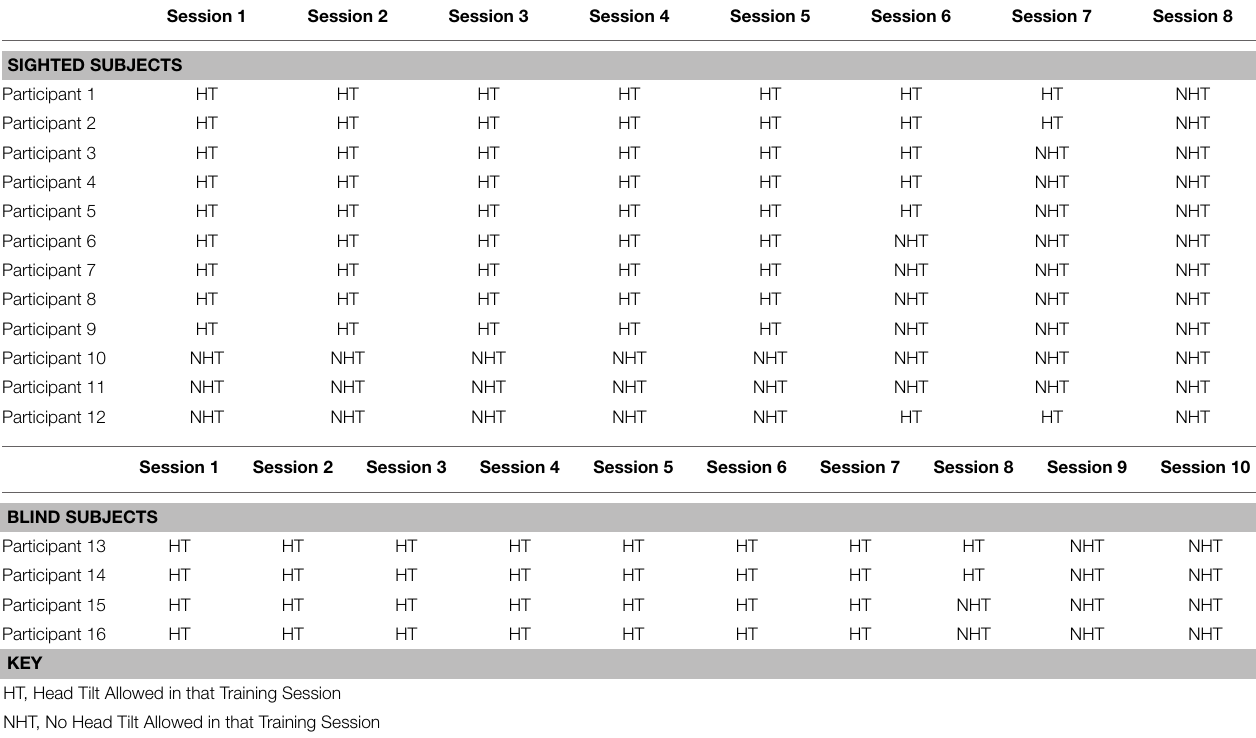
TABLE 1 | Head-tilting Sessions for vOICe Training on Length